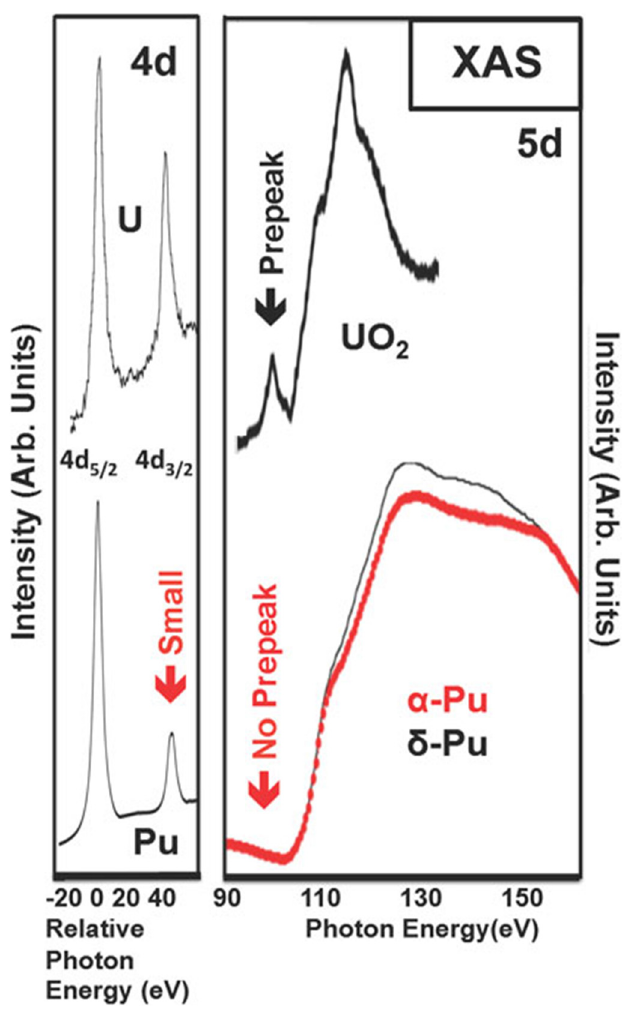
Figure 7. The N 4,5 (4d 5/2 and 4d 3/2 ) and O 4,5 (5d 5/2 and 5d 3/2 ) XAS of UO 2 (localized, n = 2) and Pu (localized, n = 5) are shown here. XAS is X-ray absorption spectroscopy. The relative photon energy is relative to the maximum of the 4d 5/2 peaks. See text for details. The figure has been taken from [38], with data from [6–8,32].